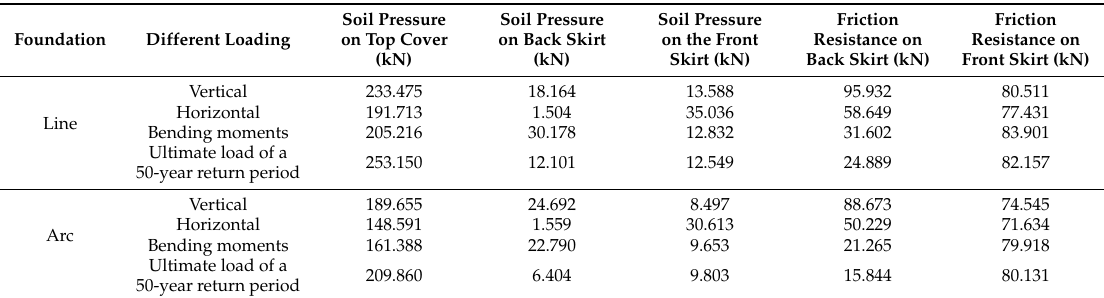
Table 2. Load bearings of different parts.